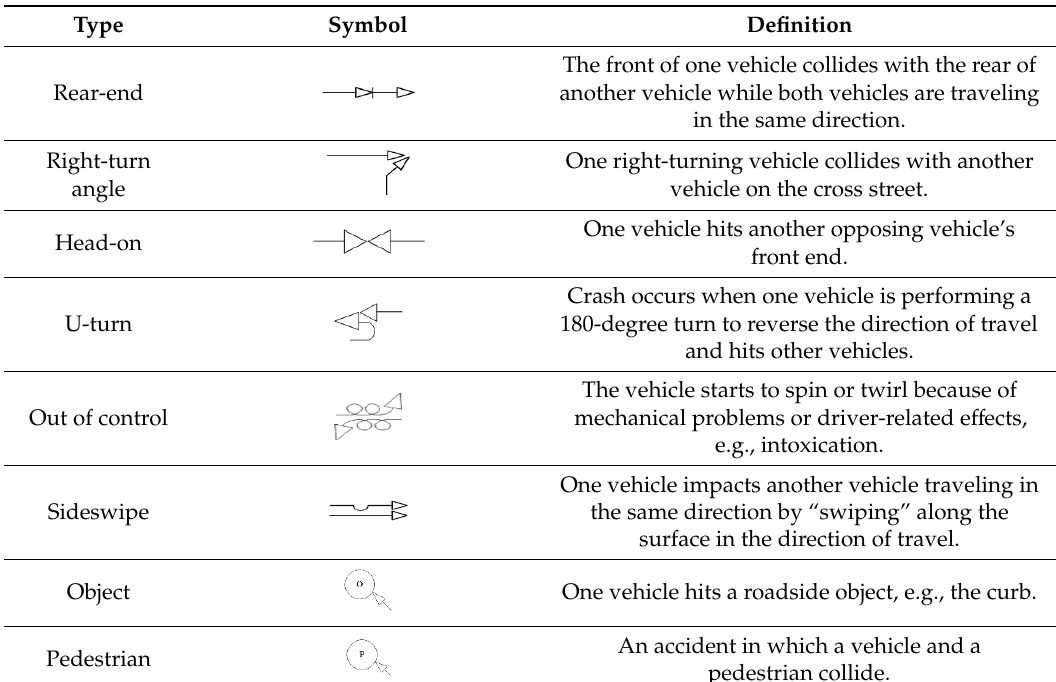
Table 1. Symbols and definitions of types of crashes in the collision diagrams.